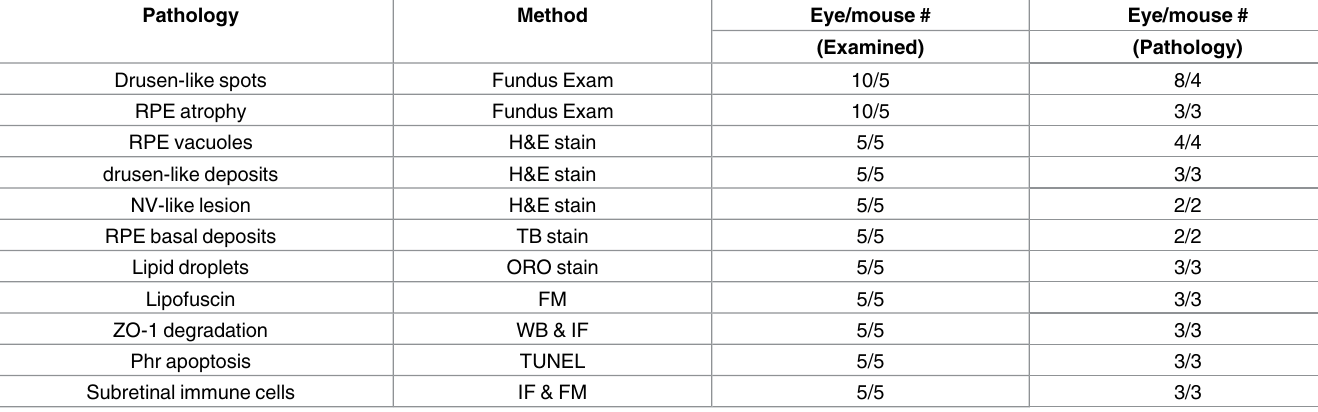
Table 1. Summaryof pathology, method, and eye/mouse numbers that were examined and had age-related